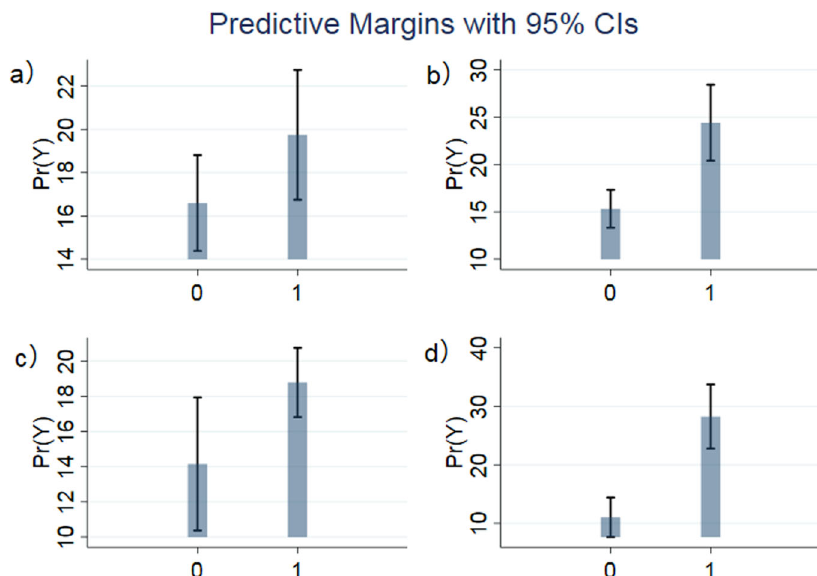
Fig. 1 Marginal effects of diet knowledge, lifestyle knowledge, and medical treatment knowledge on fl ush toilet use (based on Model 1 in Table 1). Marginal effect of diet knowledge ( a ), lifestyle knowledge ( b ), medical treatment knowledge ( c ), and all three aspects of GHK ( d ) on fl ush toilet use. The line segment is a 95% con fi dence